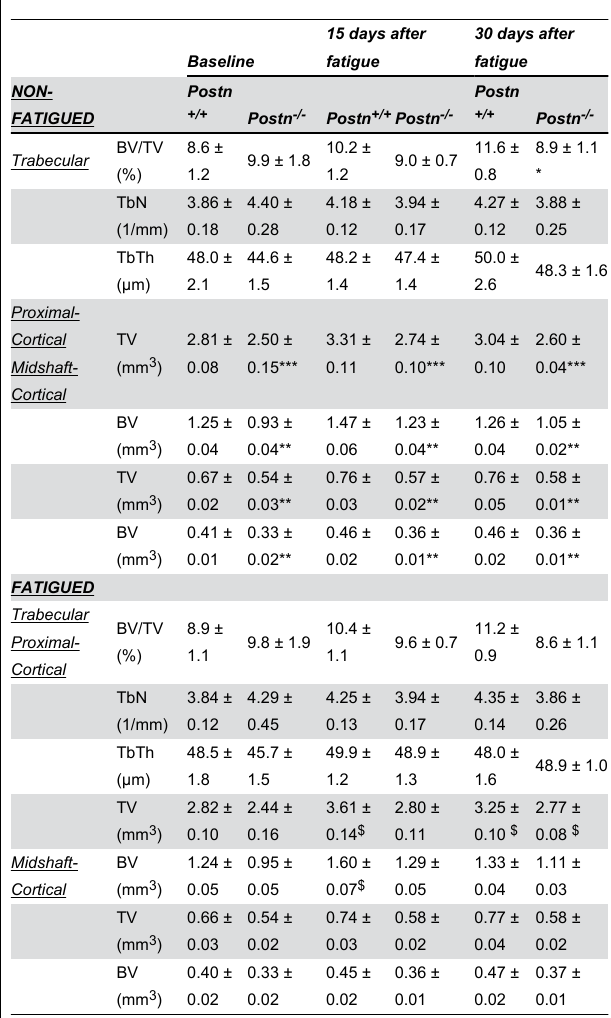
Table 1. Influence of Postn on changes of tibial bone microarchitecture in response to